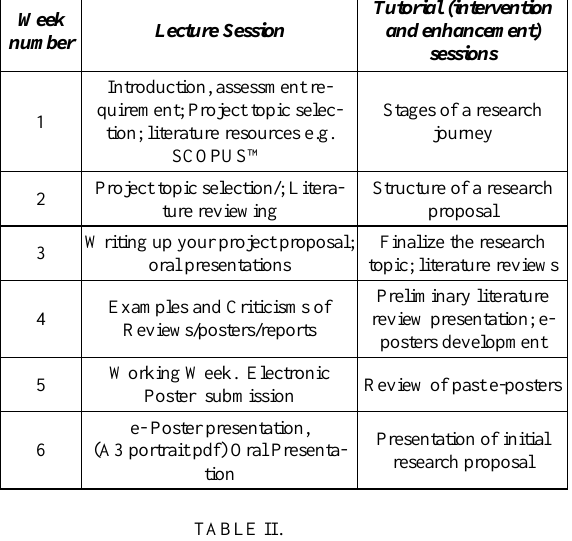
TABLE II. OUTLINE CONTENT OF THE TUTORIAL ( INTERVENTION